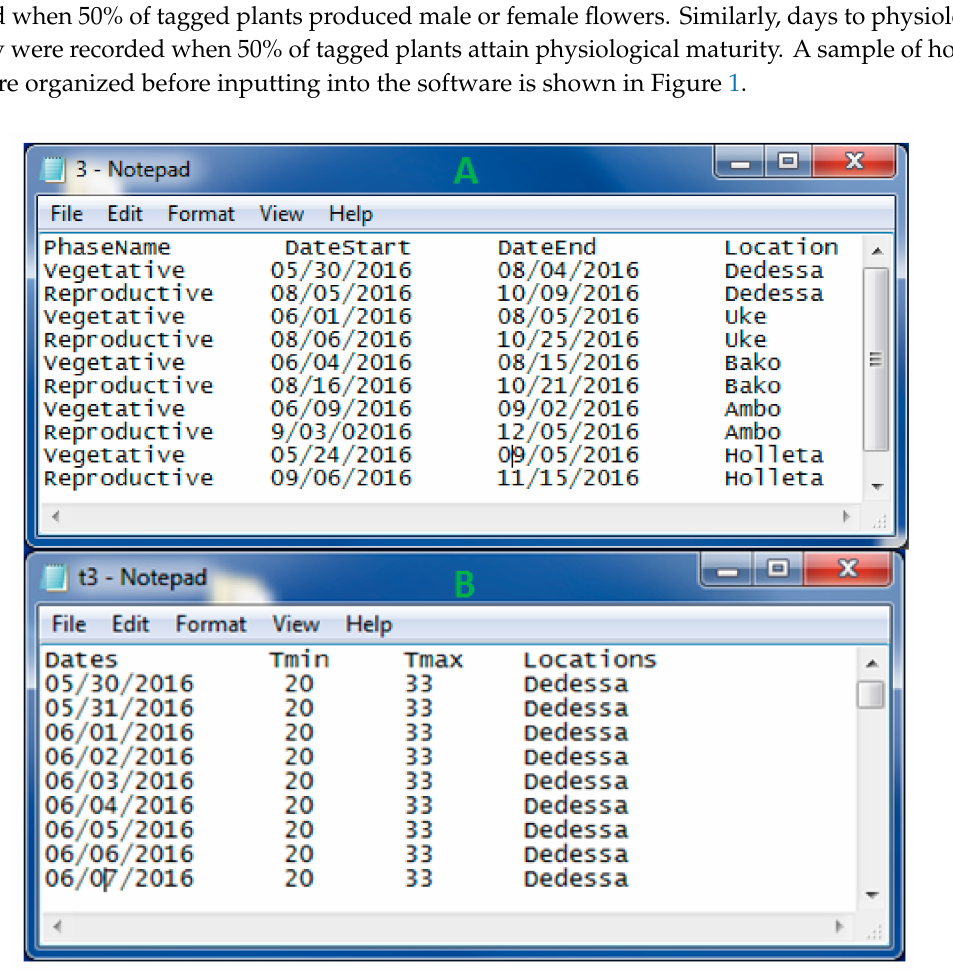
Figure 1. (A) Example of developmental phase start and end dates of a maize variety in five locations (Dedessa, Uke, Bako, Ambo, and Holleta) of Ethiopia, and (B) captures the average values of maximum and minimum temperatures in the five locations. Both files are saved as a txt-file (tab-delimited) and are used as input to plant phenology prediction and mapping (PPMaP) software. In (A), the first column indicates the developmental phase (vegetative or reproductive) of maize, the second column indicates the starting date of the phase, and the third column is the end date of the phase. Column four is the location in which the experimental trial was conducted. In (B), column one is the date of capture, column two, and three the minimum and maximum values of temperature respectively, while column four is the name of the location where the trails were